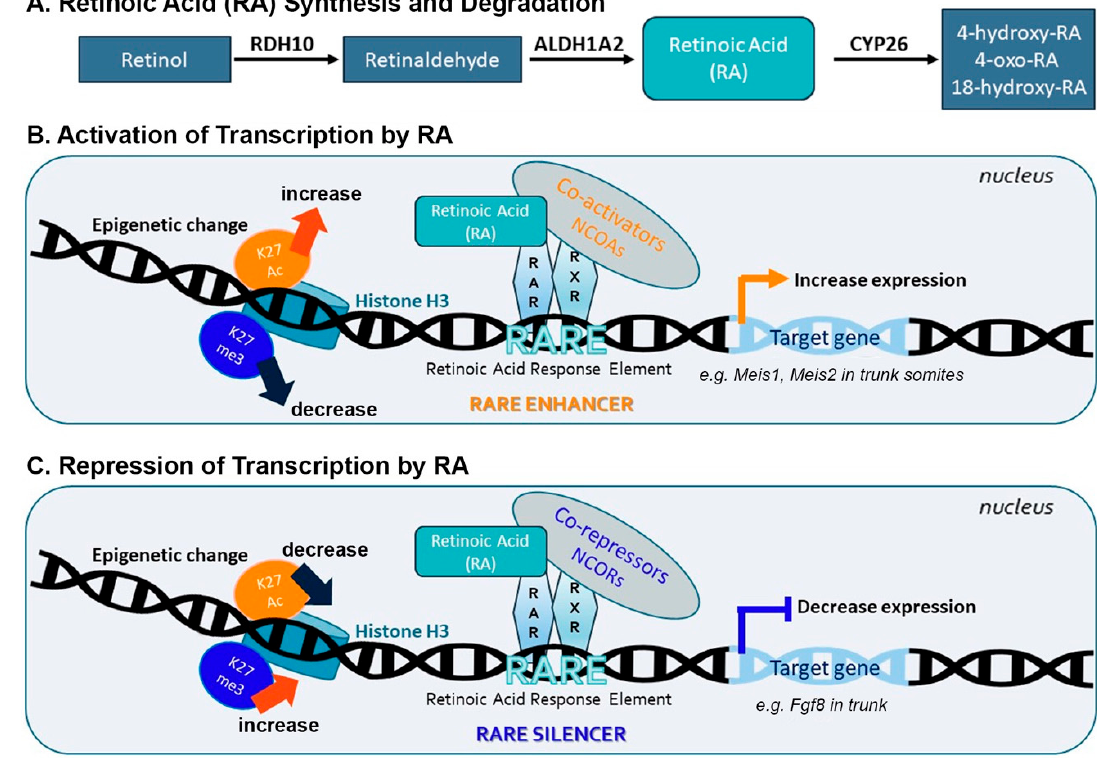
Figure 1. Generation of retinoic acid (RA) and molecular mechanism used by RA to control transcriptional activation or repression of target genes. ( A ) RA is synthesized by sequential conversion of retinol (vitamin A) to retinaldehyde by retinol dehydrogenase 10 (RDH10), followed by metabolism of retinaldehyde to RA. RA can be degraded by CYP26 enzymes. ( B , C ) The heterodimer formed by nuclear RA receptors (RARs) complexed with retinoid X receptors (RXRs) binds noncoding DNA sequences called RA response elements (RAREs). Binding of RA to RAR creates conformational changes that alter the recruitment of nuclear receptor coactivators (NCOAs) or nuclear receptor corepressors (NCORs) leading to a change in the appearance of epigenetic marks on histone H3, i.e., lysine 27 acetylation (K27ac) associated with gene activation or lysine 27 trimethylation (K27me3) associated with gene repression. In the presence of RA, RARE enhancers stimulate recruitment of NCOAs that result in a nearby increase in H3K27ac and/or decrease in H3K27me3 leading to increased target gene expression such as Meis1 and Meis2 in embryonic trunk tissue ( B ). In the presence of RA, RARE silencers stimulate recruitment of NCORs that result in a nearby decrease in H3K27ac and/or increase in H3K27me3 leading to decreased target gene expression such as Fgf8 in embryonic trunk tissue ( C ).